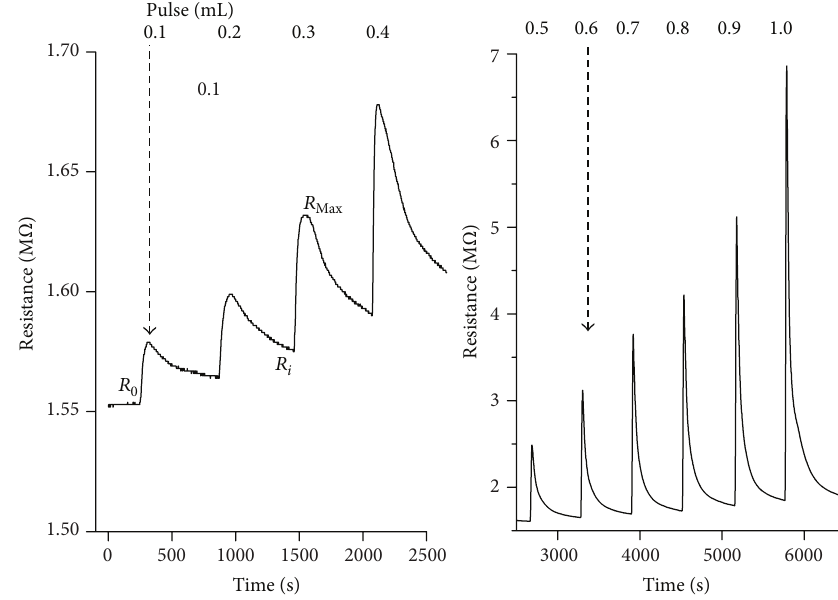
Figure 3: Progressive sensing test from 0.1 to 1mL of THF for PST 3 sample.